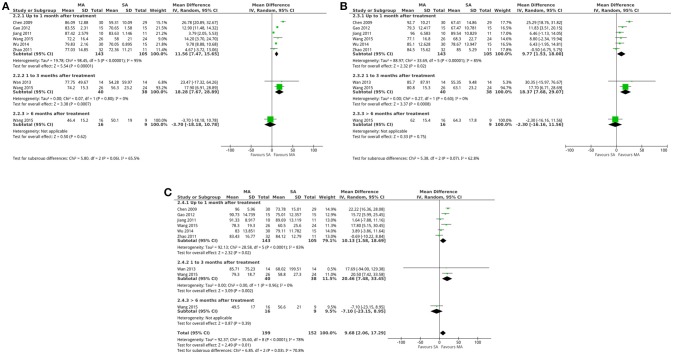
Forest plot: (A) acupuncture vs. sham acupuncture- MSQ scores: (A) role function-restrictive; (B) role function-preventive; (C) emotional function. MA, manual acupuncture; SA, sham acupuncture.